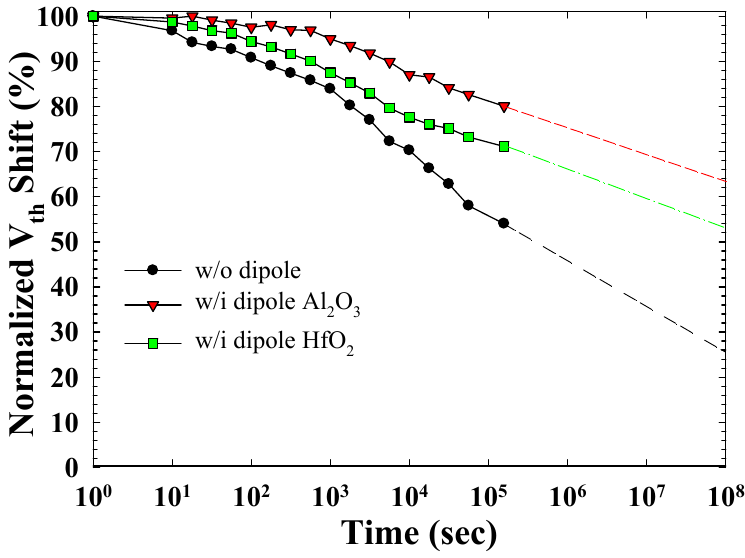
Figure 6. Retention characteristics of the TAHOS NVM